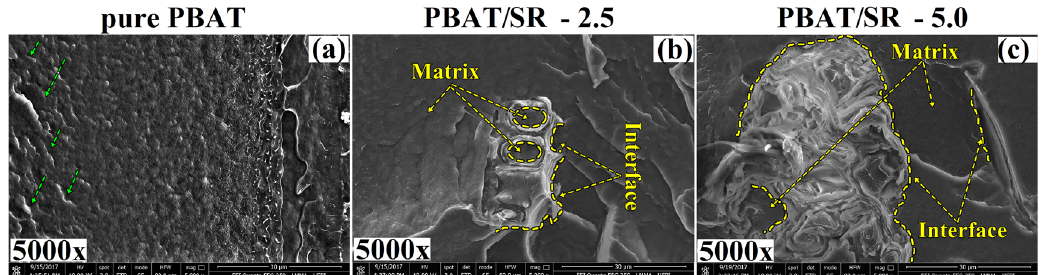
Figure 5. Scanning electron microscopy of fractured surface: a) pure PBAT and PBAT/SR mulch films without carnauba wax: b) 2.5% and c) with 5.0%. (colored in the online version)